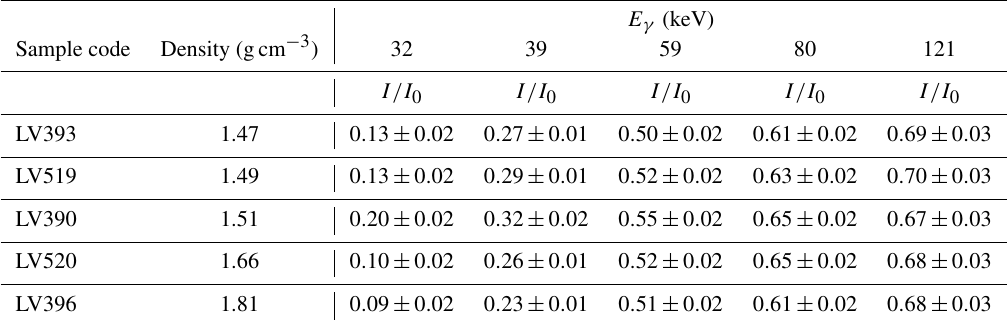
Table 4. Transmitted intensities of gamma rays for sandy samples with different densities (and chemical composition). I/I 0 is the ratio between experimentally measured gamma-ray intensity ( I ) and gamma-ray intensity without a sample ( I 0 ). Gamma energies ( E γ ; keV) of point sources are 32 ( 137 Cs), 39 ( 152 Eu), 59 ( 241 Am), 80 ( 133 Ba), and 121 ( 152 Eu) (Abdualhadi, 2016). E γ (keV)